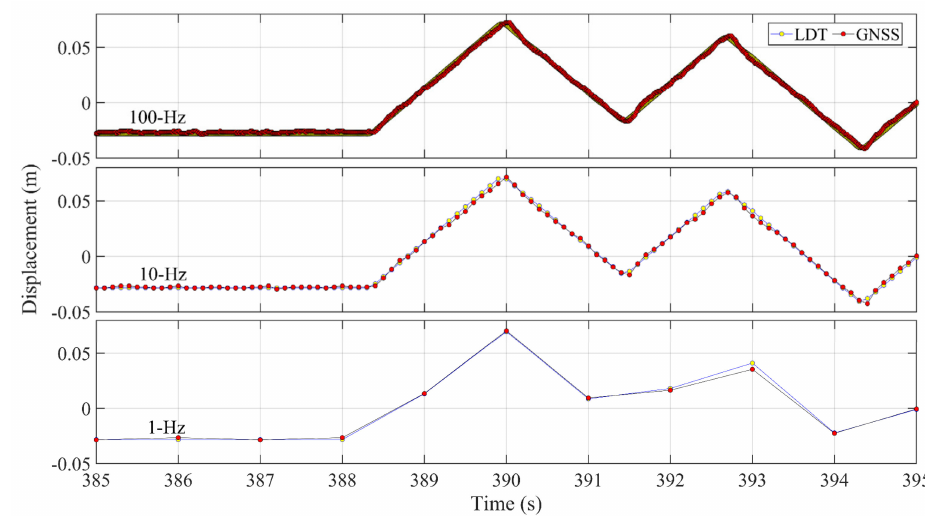
Figure 14. Comparison between 100-Hz, 10-Hz, and 1-Hz GNSS time series (red dots) and laser displacement transducer (yellow dots) for the third sinusoidal motion.